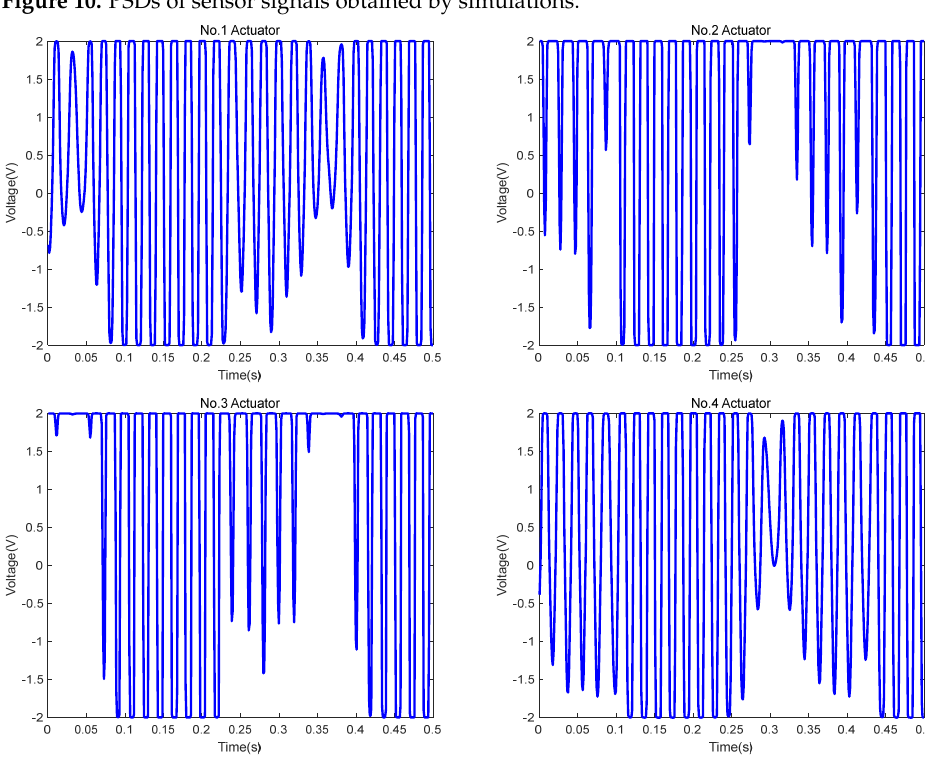
Figure 11. Actuator control signals obtained by simulations (1 V represents 12.3 N).